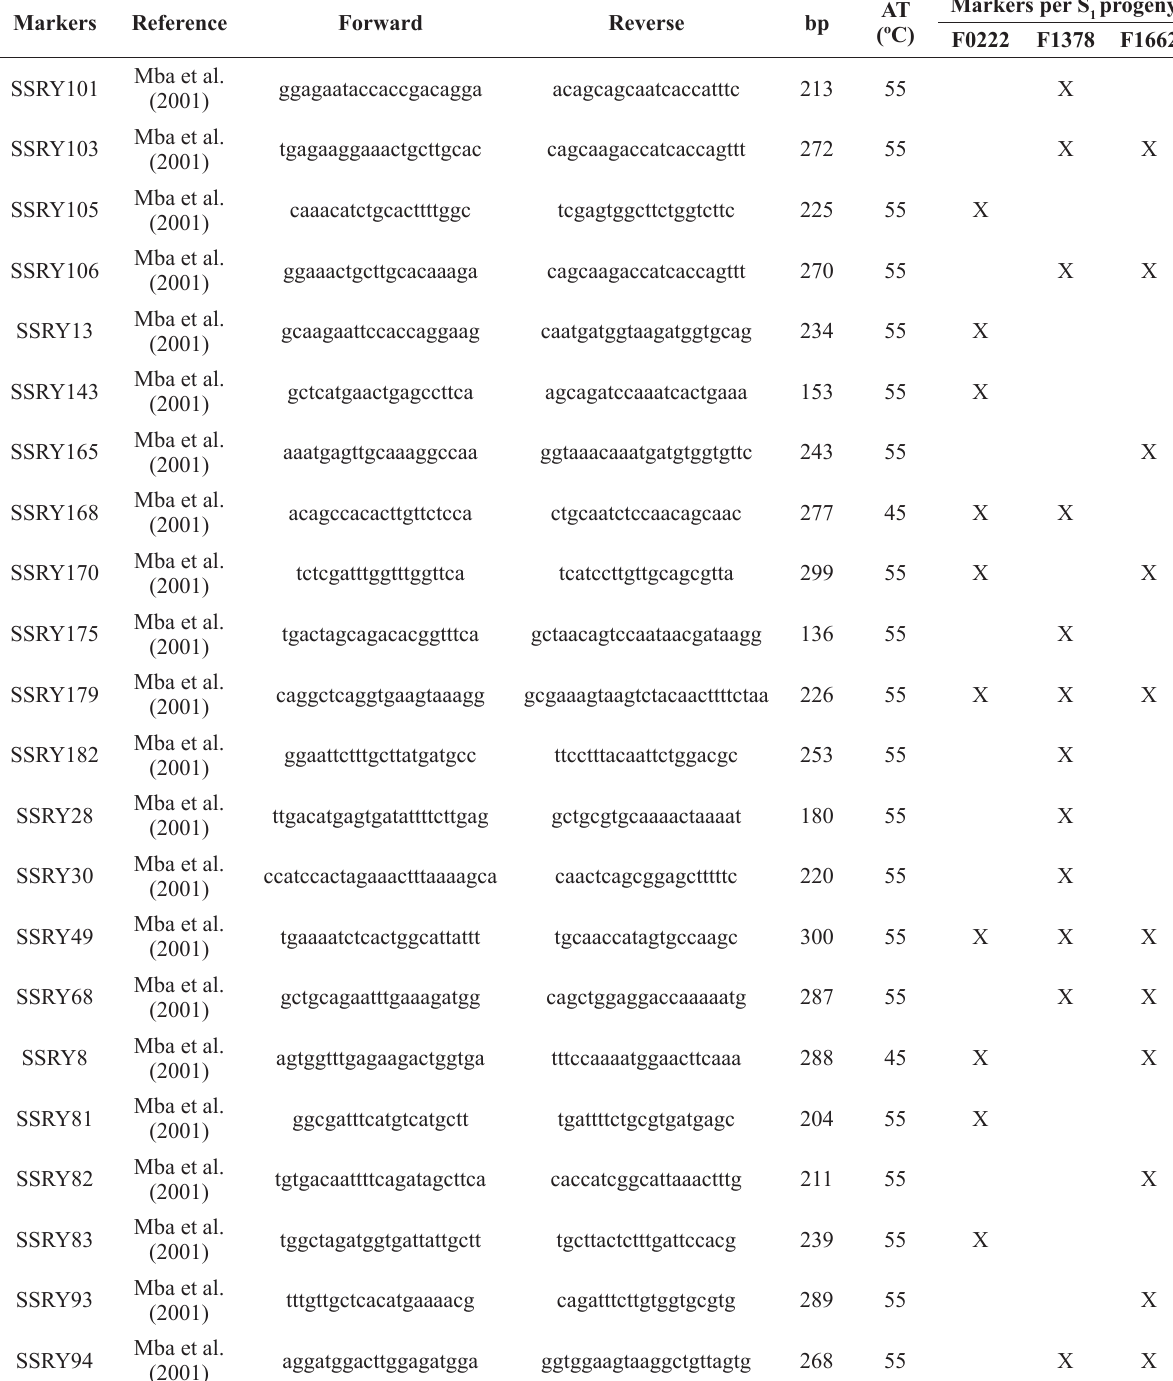
Microsatellite (SSRY and EME series) and minisatellites markers (VNTR) were used to evaluate the inbreeding coefficient cassava individuals in self-pollination progenies from BGM0222 (F0222), BGM1378 (F1378) and BGM1662 (F1662) in S 1 cassava